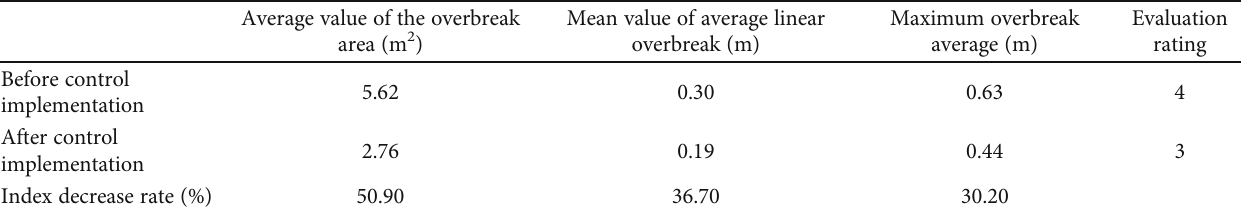
Table 6: Comprehensive comparison of controlled and uncontrolled systems for tunnel smooth